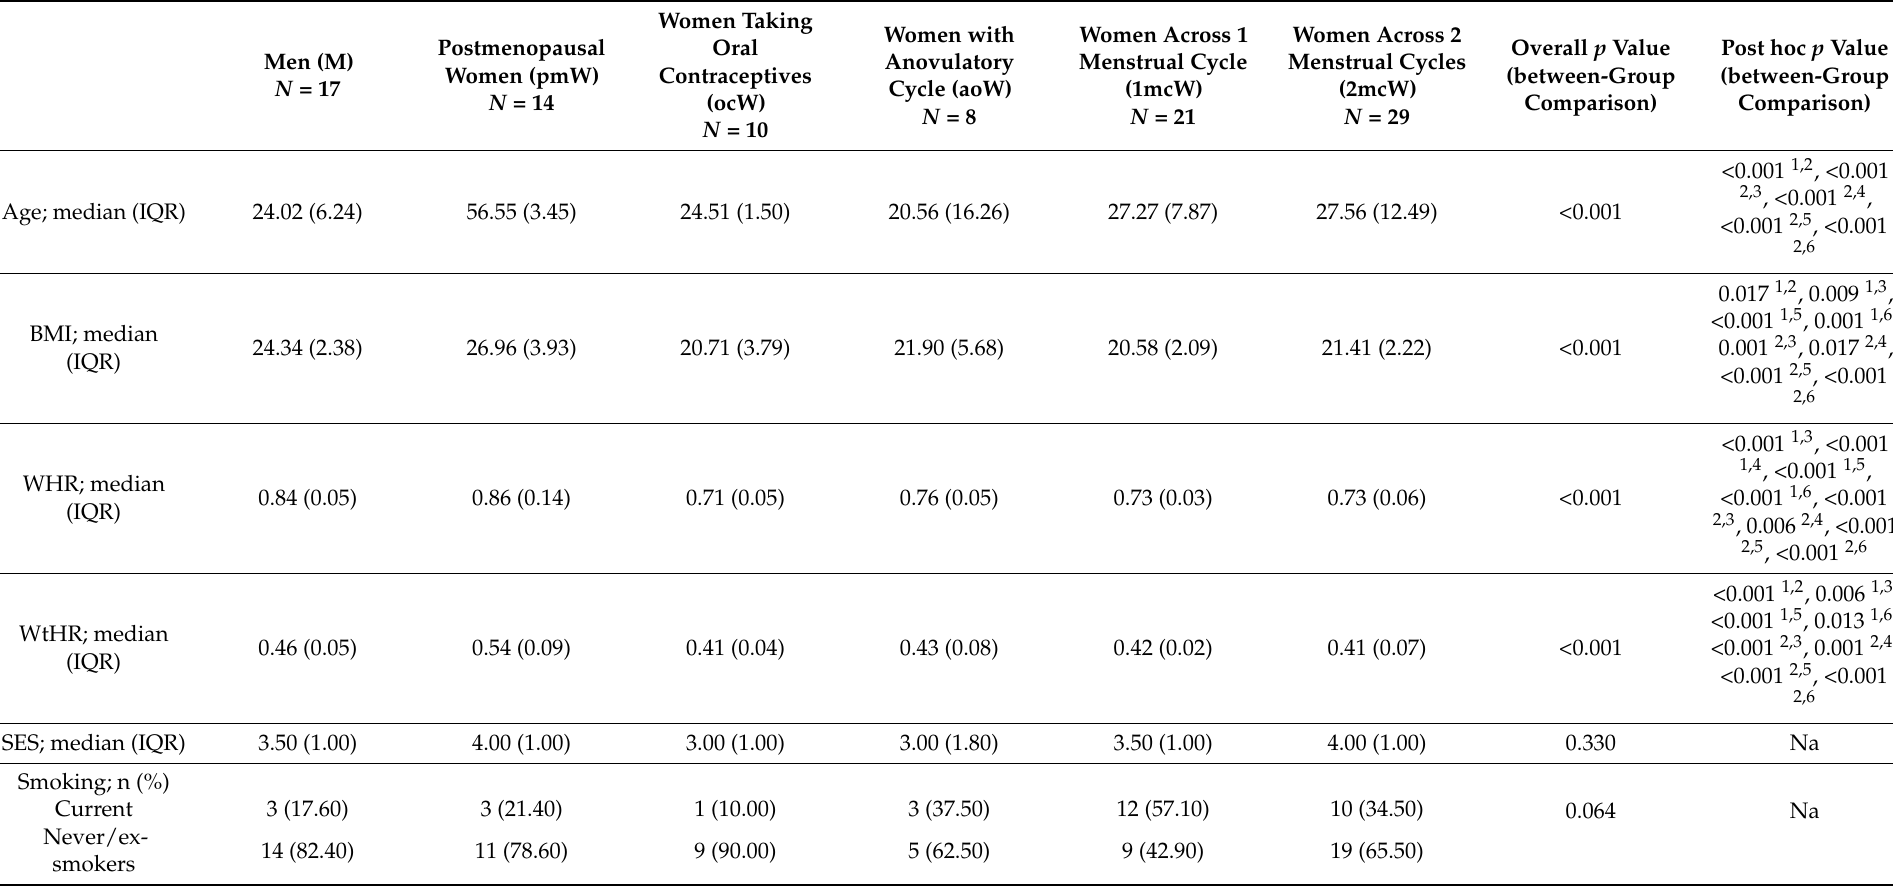
Table 1. Characteristics of the